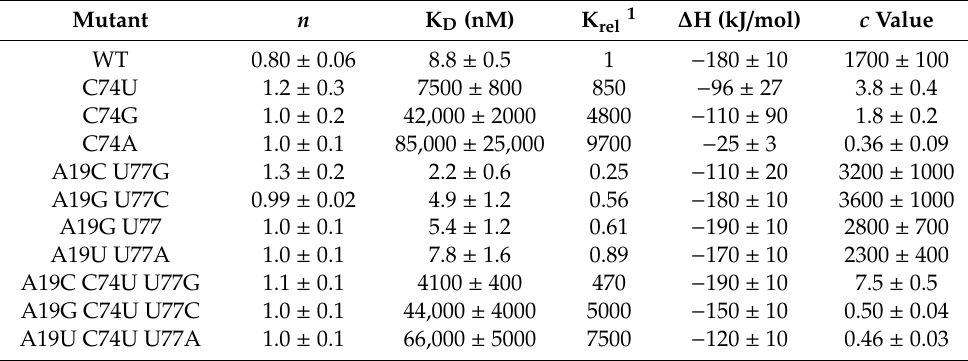
Table 2. ITC of N 2-phenoxyacetyl guanine with mutants of GR RNA.